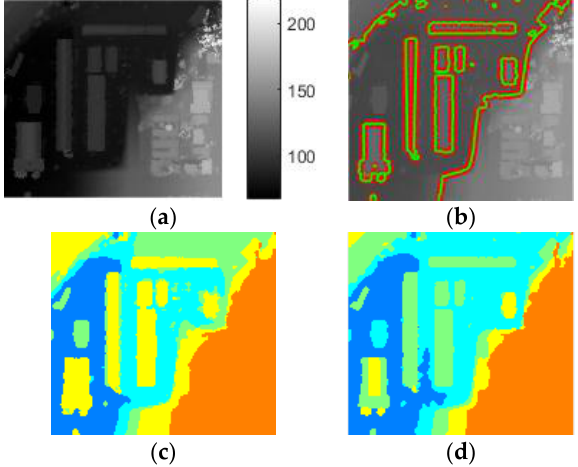
Figure 15. Original DSM and segmentation results of Dataset 3. ( a ) DSM ( b ) Level-set; ( c ) ORTSEG; ( d ) LS-ORTSEG. ‘Hist.wSize’ = 3, ‘NumTextures’ = 7 for both ORTSEG and LS-ORTSEG. Table 2. Accuracy of different methods.